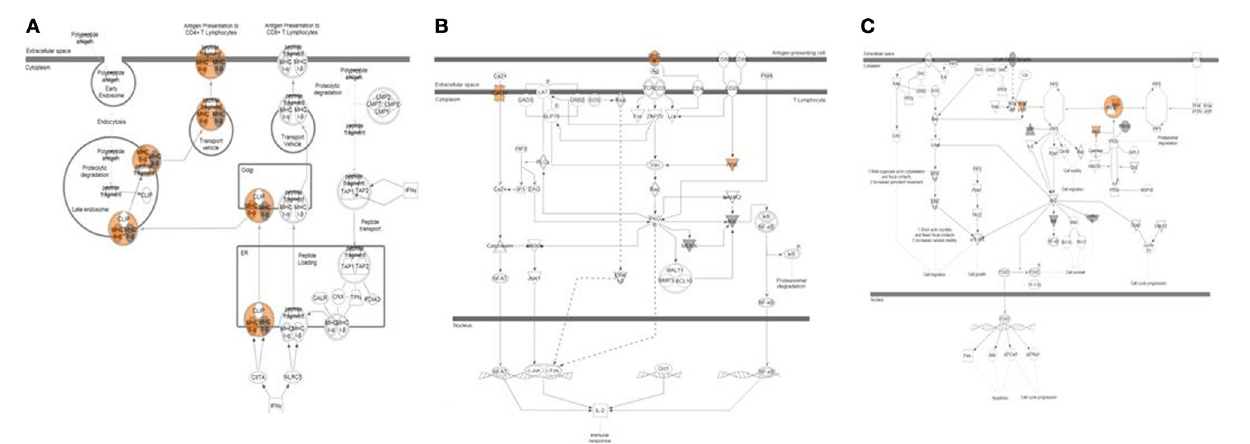
FIGURE 5 | Pathway analysis of top variants from exome sequencing data. Three pathways highly enriched with non-synonymous variants found exclusively in relapse patients are shown. (A) Antigen presentation pathway affected in 8 relapse cases shown. Variants with predicted activation effect